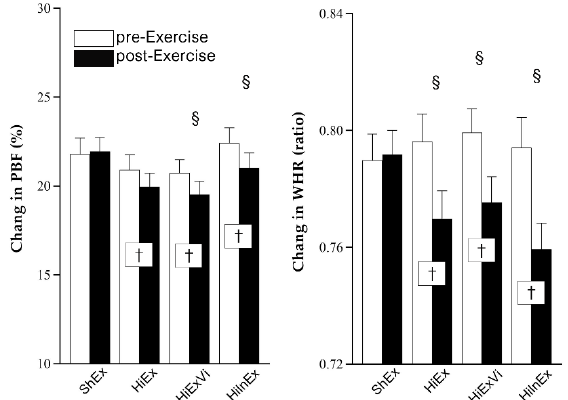
Figure 2. The change in percent of body fat (PBF) and waist–hip ratio (WHR). ShEx—sham exercise; HiEx—high-impact exercise; HiExVi—high-impact exercise with various directions; HiInEx—high- intensity interval exercise. Data are presented as mean ± standard deviation (SD). † indicates that the difference between pre- and post-exercise is significant ( p < 0.05). § denotes that the difference in change magnitude is significant in HiEx, HiExVi, and HiInEx groups compared with ShEx group ( p < 0.05).